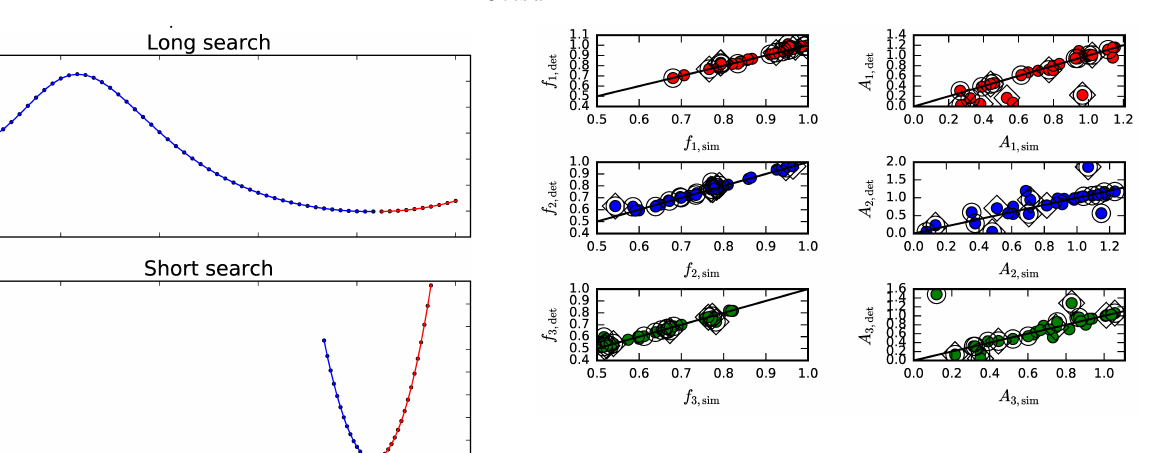
Fig. 11.— Thirty simulated data samples created with three sig- nal model 18. Left hand panels show simulated f i , sim and de- tected f i , det frequencies. Right hand panels show respective am- plitudes. Highlighted models fulfill criteria of Eq. 28 (Transparent diamonds) and Eq. 29 (Transparent circles). Continuous lines de- note equal simulated and detected levels. Symbol colours are given in Table